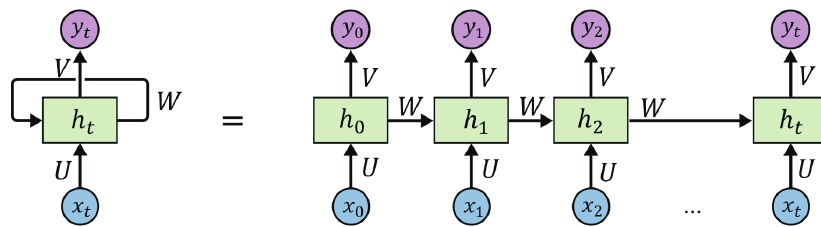
Figure 7. Recurrent neural